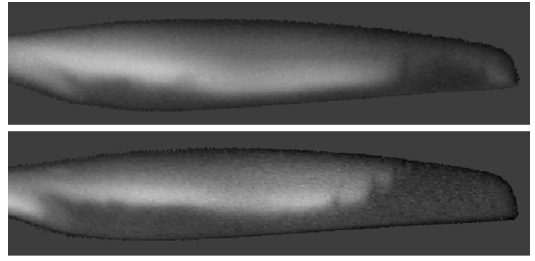
Figure 2. Processed infrared images of rotor R18x6: (top) at f 1 = 50 Hz; (bottom) at f 3 = 100